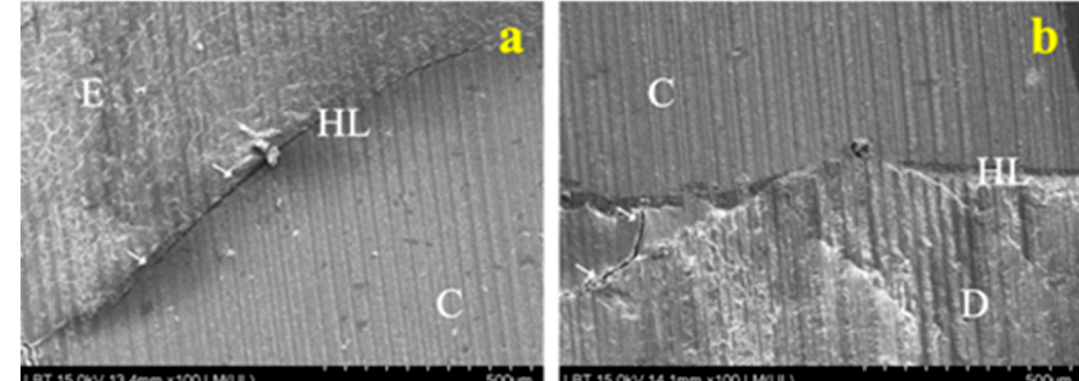
Figure 7. SEM images for Score 3: ( a ) Composite (C)—enamel interface (E); ( b ) Composite (C)—dentin (D) interface; HL—hybrid layer.